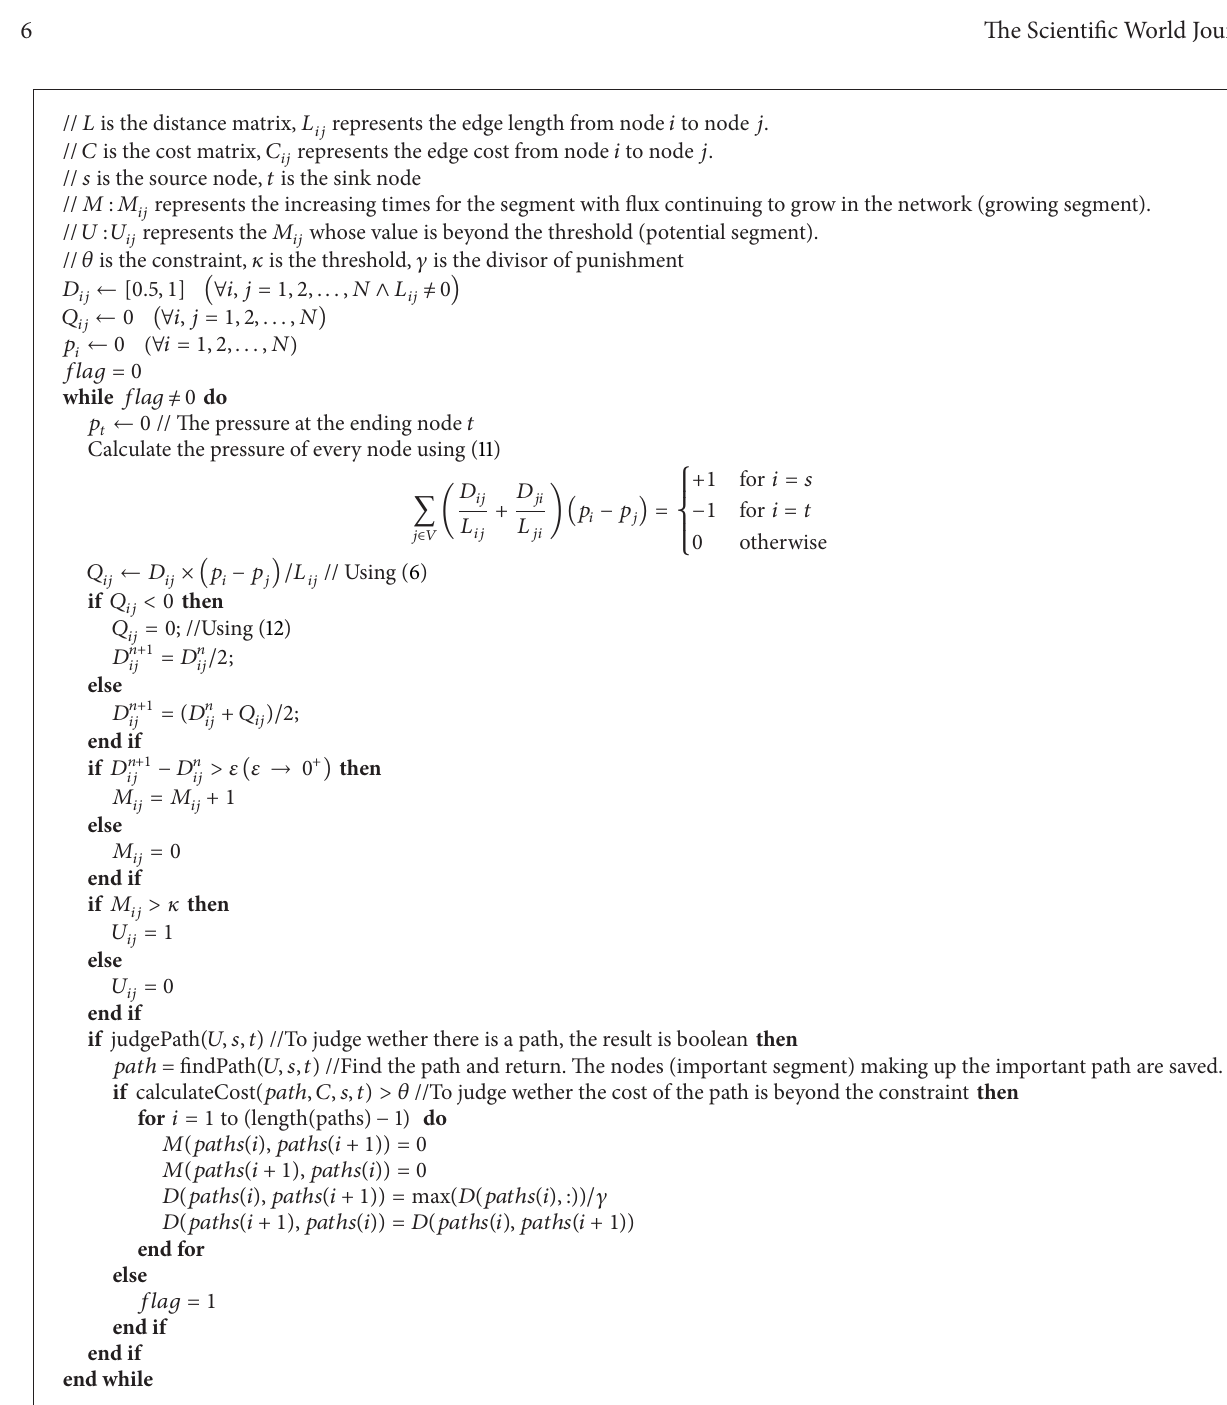
Algorithm 1: A bioinspired method for the constrained shortest path